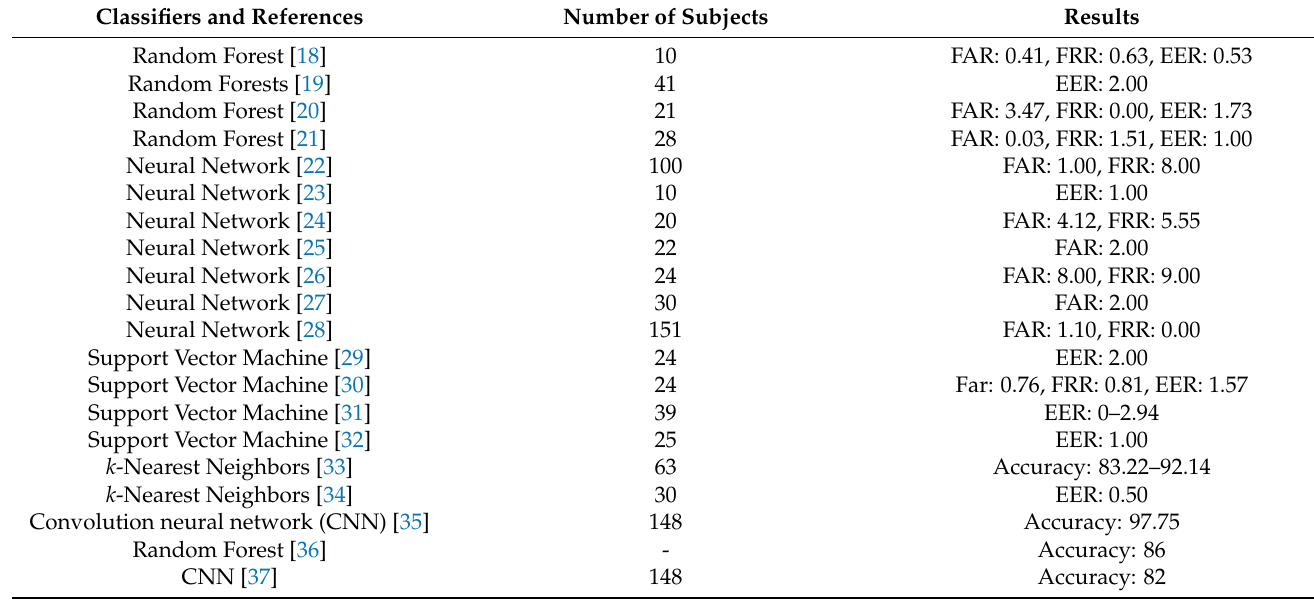
Table 1. Classification based on popular discriminative models.